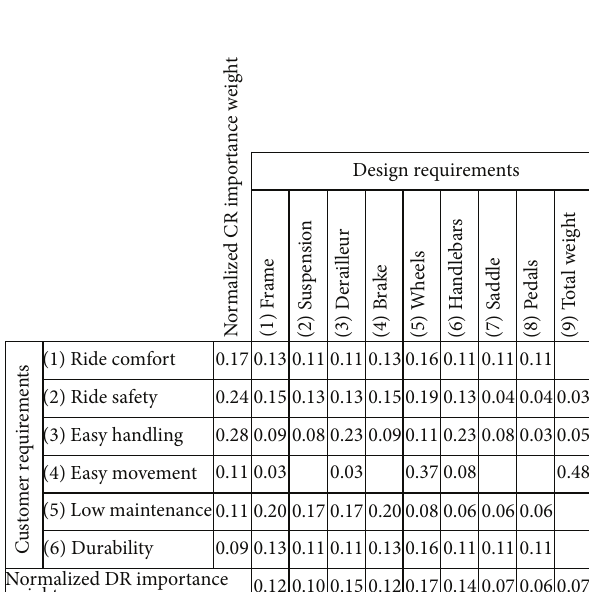
Figure 4: Basic QFD design information for product.